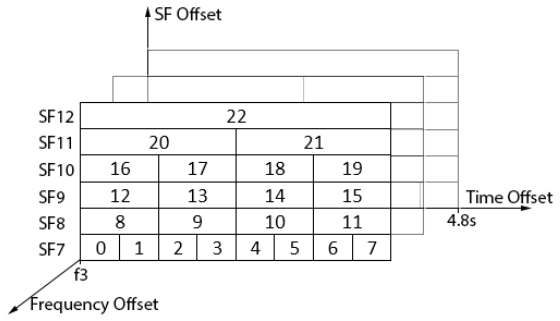
Figure 6. Frame structure in TSSFH.